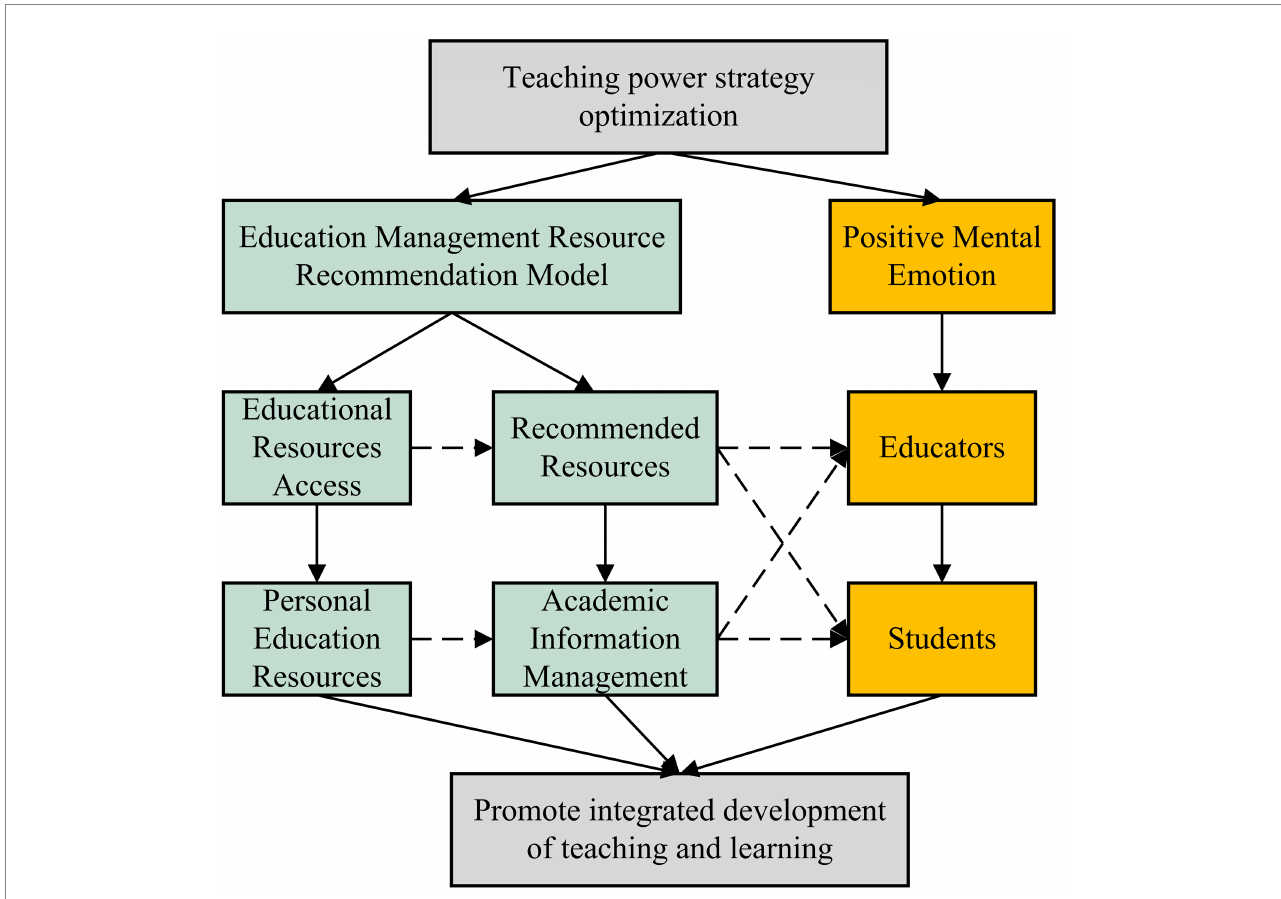
FIGURE 3 Design of research